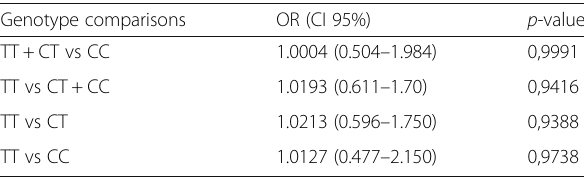
Table 2 Case-control association analysis of COL5A1 rs12722 variant by combined genotype distributions Genotype